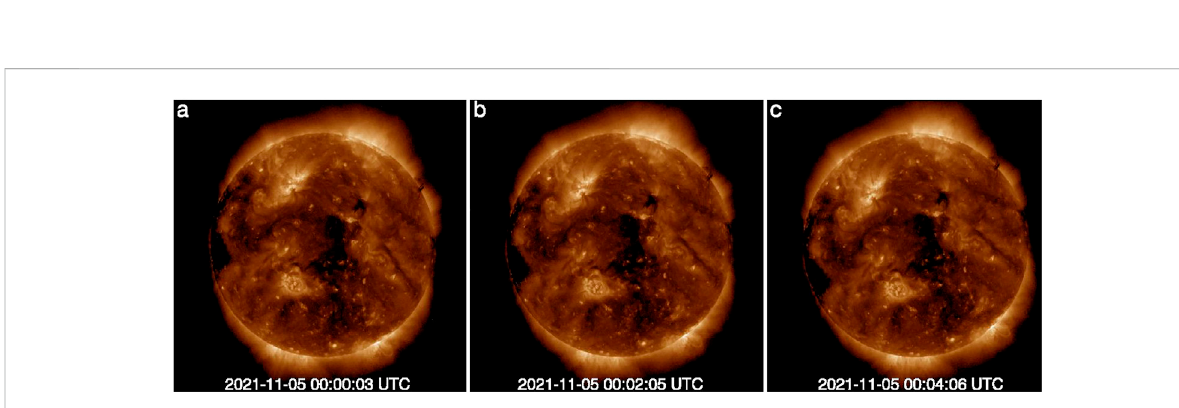
FIGURE 3 Solarimagesin19.5 nmobservedbyX-EUVIon5November2021.Thetimeof3ais00:00:03UTC,thetimeof3bis00:02:05UTC,andthetime of 3c is 00:04:06 UTC.